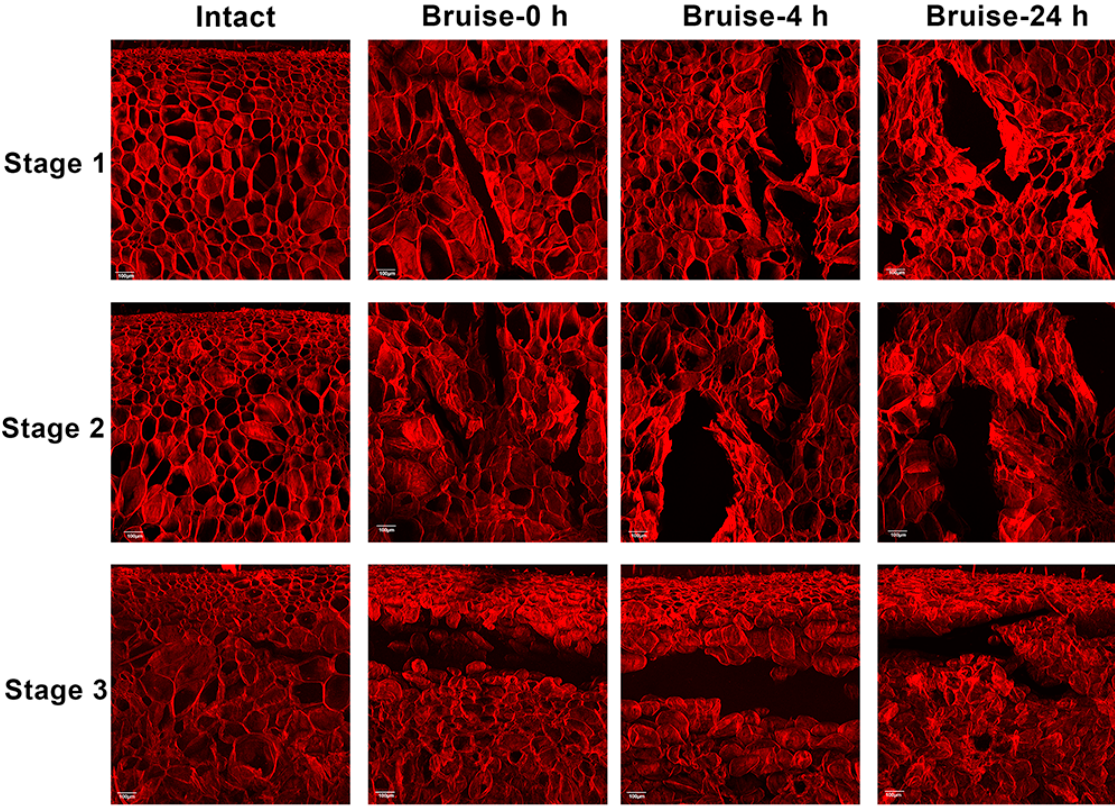
Figure 3. Confocal laser scanning microscopic images of a cross-section of intact and bruised peach flesh tissue for three maturity stages (stage 1–3) and three detection times after bruising (the white ruler shown in the image represents 100 μ m).